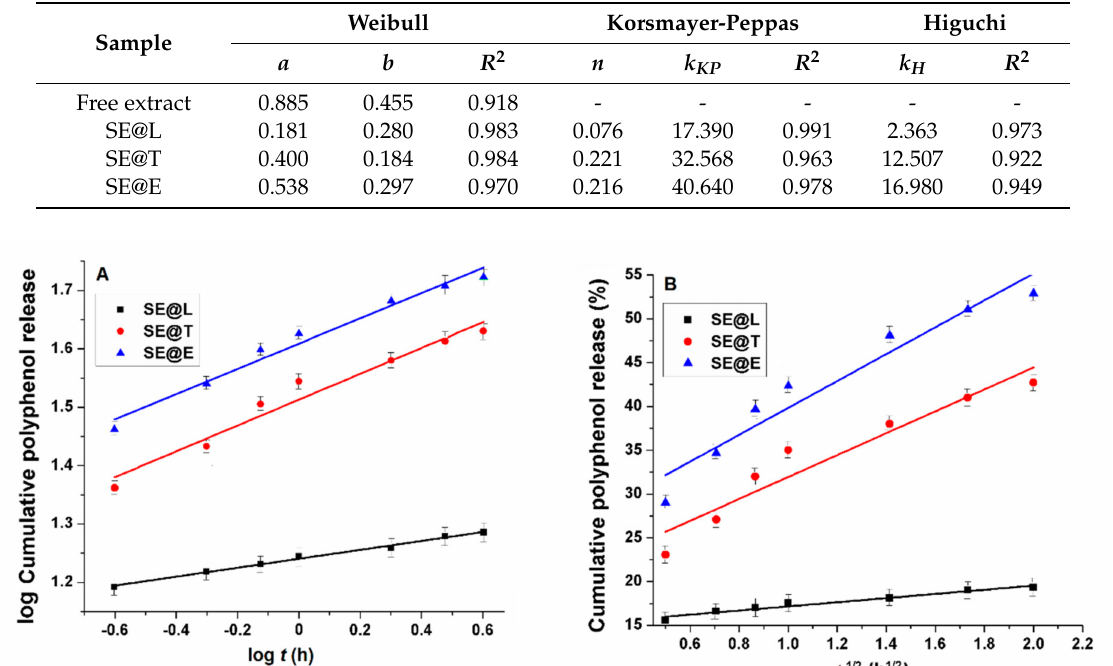
Table 2. Correlation coe ffi cients and parameters of the fitted experimental data.